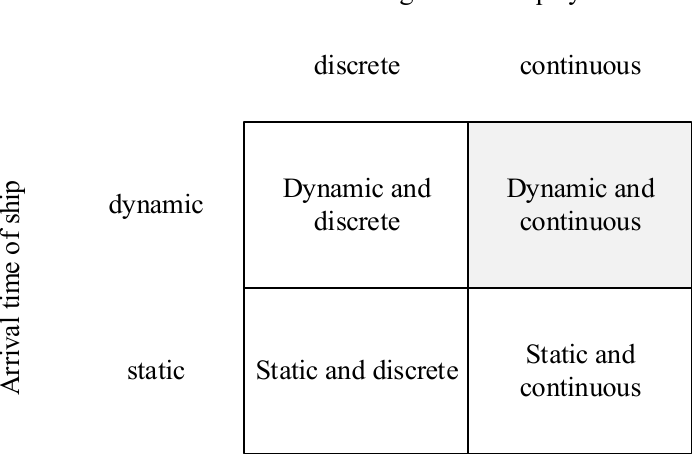
Figure 1. The berth allocation problem (BAP) variants.